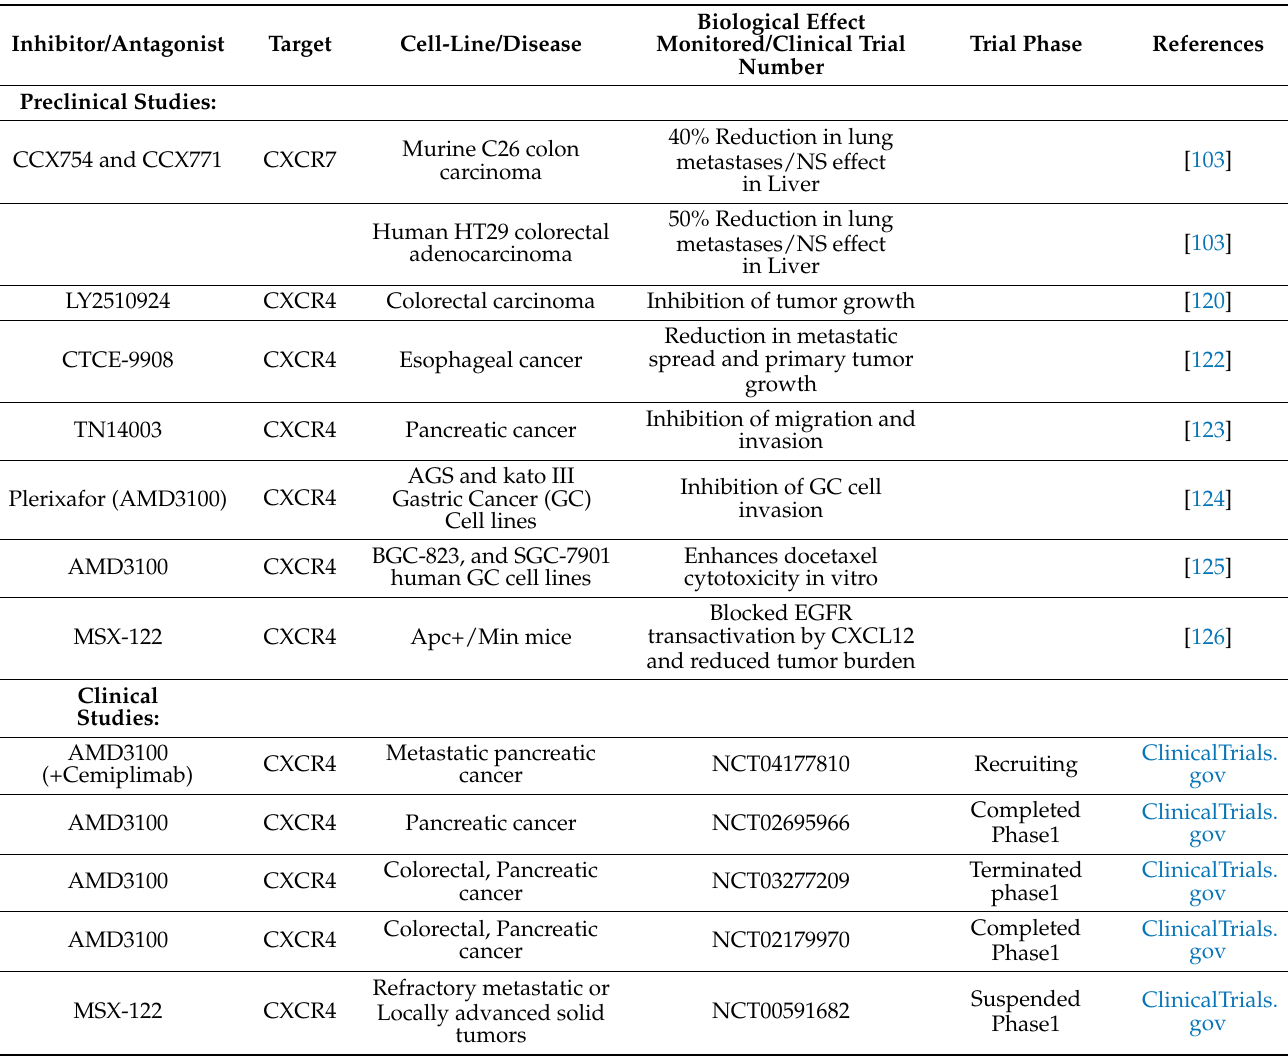
Table 1. Modulators of CXCL12–CXCR4/CXCR7 axis in preclinical and clinical studies of gastrointestinal cancers.